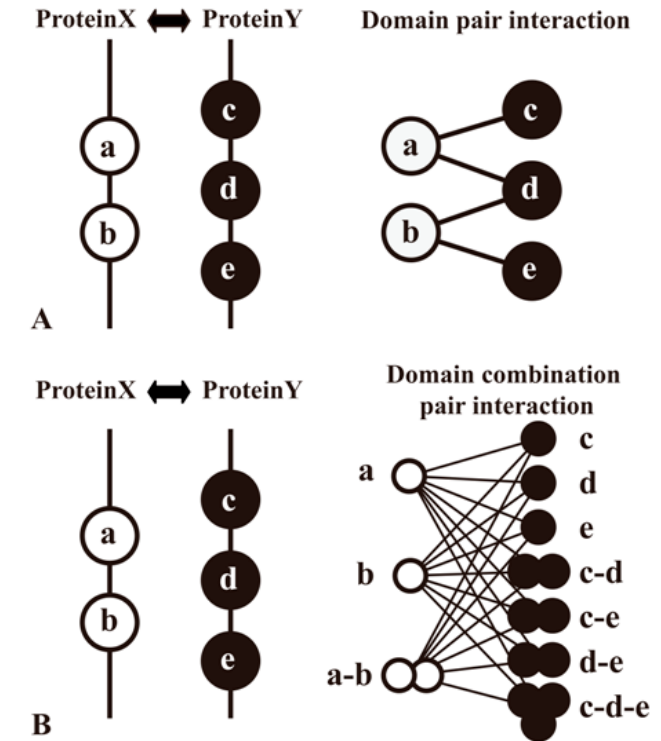
Figure 4. Two methods to predict domain − domain interactions (DDIs) from PPIs. Proteins A and B are a pair of proteins in a PPI network. Protein A contains domains a and b, whereas protein B contains domains c, d and e. PPI is interpreted as the result of interactions among multiple domain pairs. ( A ) A method that considers a domain pair as basic unit of protein interactions; ( B ) Another method that proposes a domain combination pair as a basic unit for the prediction model [83].